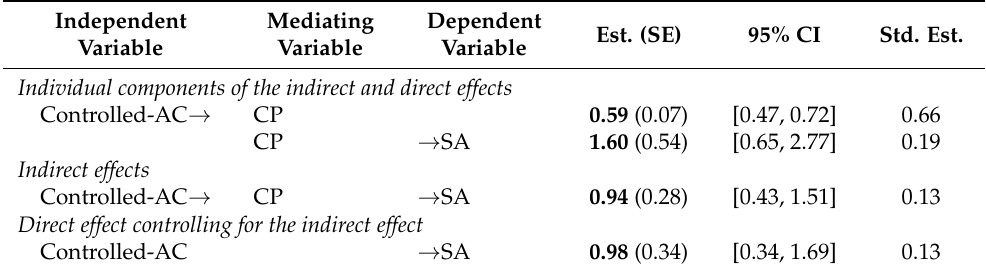
Table 2. Results of the Mediation Analysis for Controlled-Appetitive Cyberaggression: Indirect and Direct